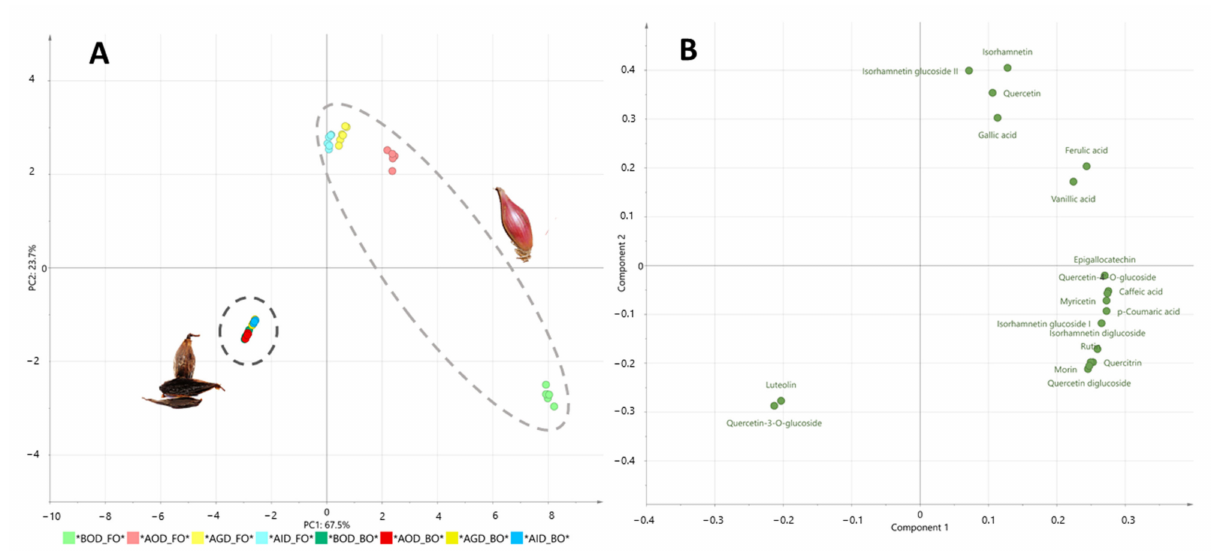
Figure 1. Scores ( A ) and loadings ( B ) obtained in the Principal Component Analysis (PCA) comparing data from polyphenols in fresh and black onion during simulated gastrointestinal